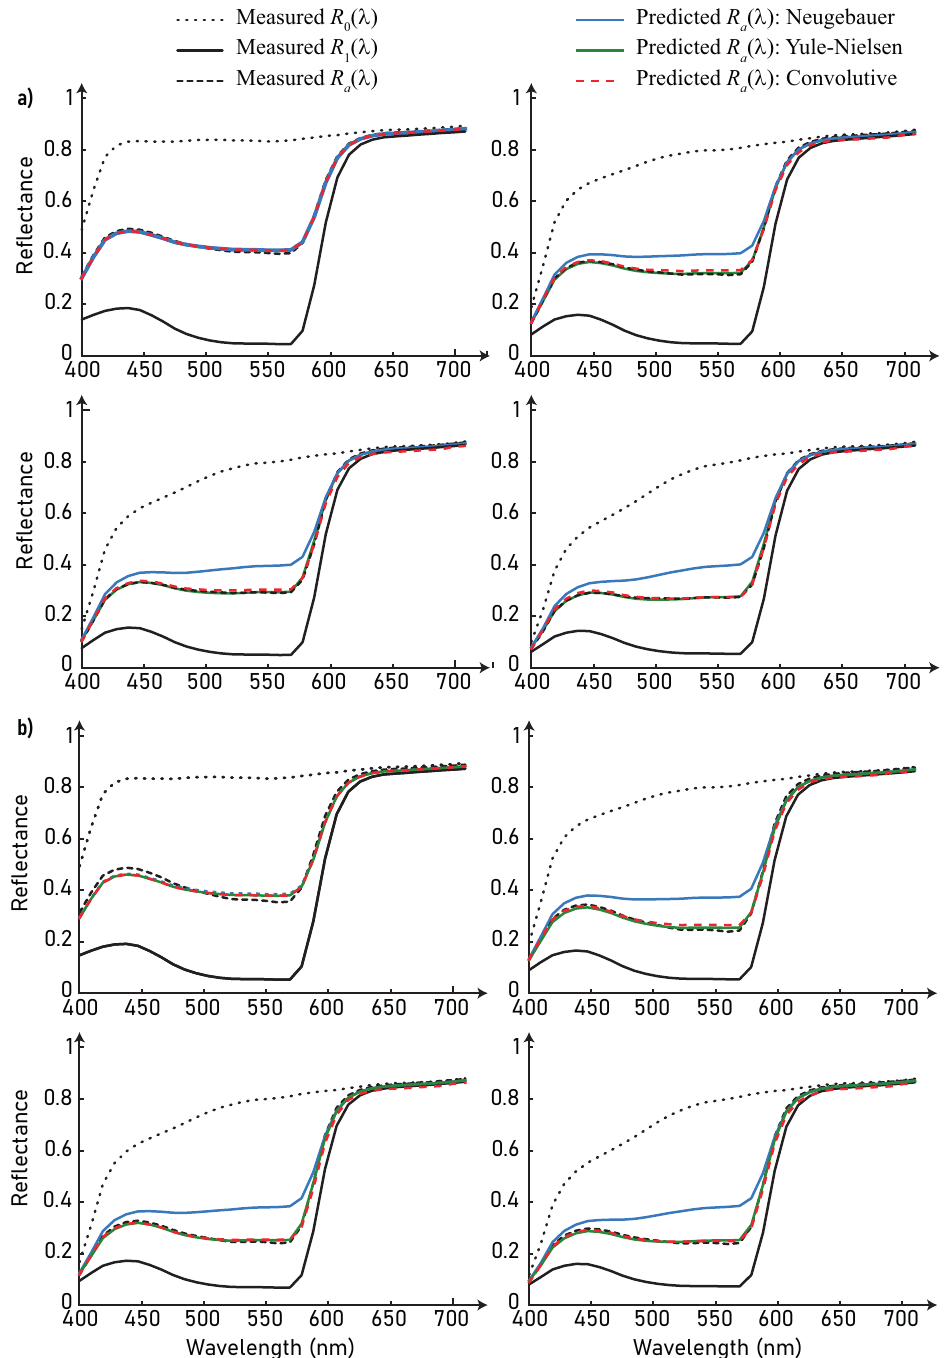
Figure 6. Measured and predicted reflectances of magenta line halftones of period ( a ) 1.69 mm; ( b ) 0.68 mm, with different varnish thicknesses: without varnish ( top left ); one layer ( top right ); two layers ( bottom left ) and three layers ( bottom right